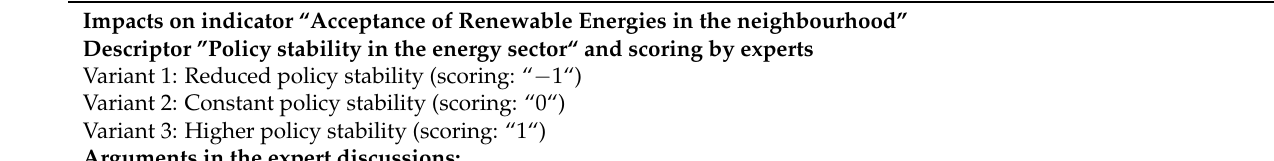
Table 2. Example of the line of argumentation for descriptor impacts on indicators estimated in the expert panels for the indicator “Acceptance of Renewable Energies in the